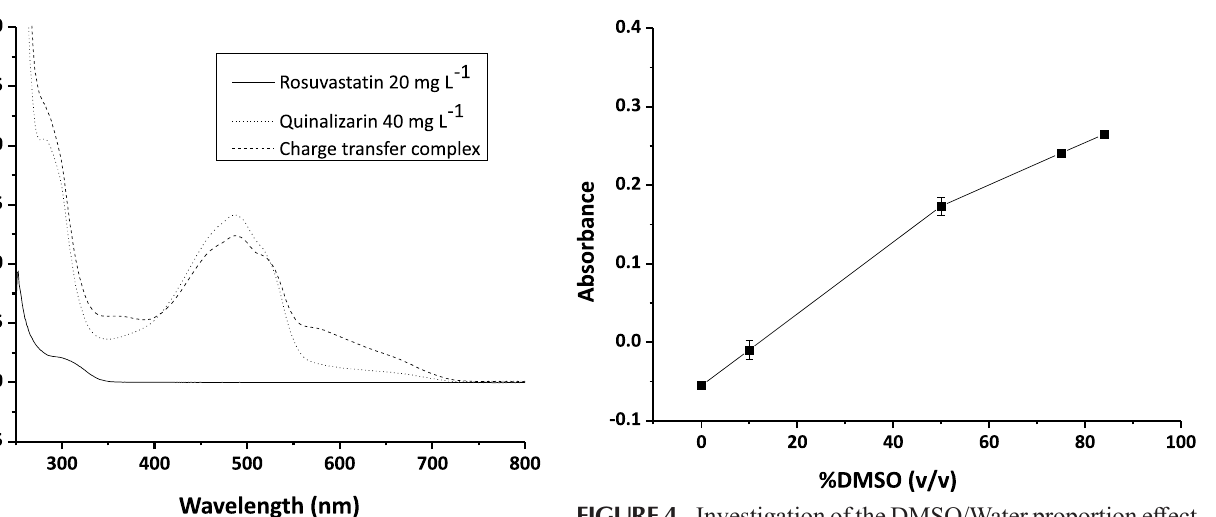
FIGURE 4 - Investigation of the DMSO/Water proportion effect on the analytical signal. Experimental conditions: quinalizarin: